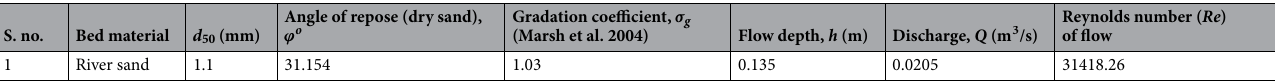
Table 3. Details of various experimental parameters.